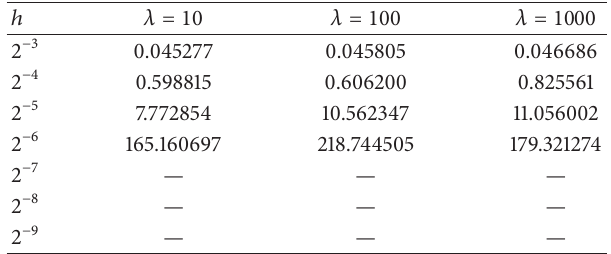
Table 2: The CPU times for nonsmooth SOR-Newton algorithm. Table 3: The CPU times for active set method in